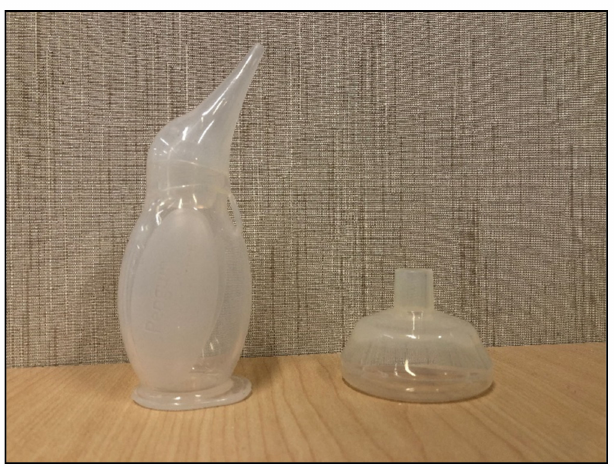
Figure 1. Examples of resuscitation equipment; Image A. White